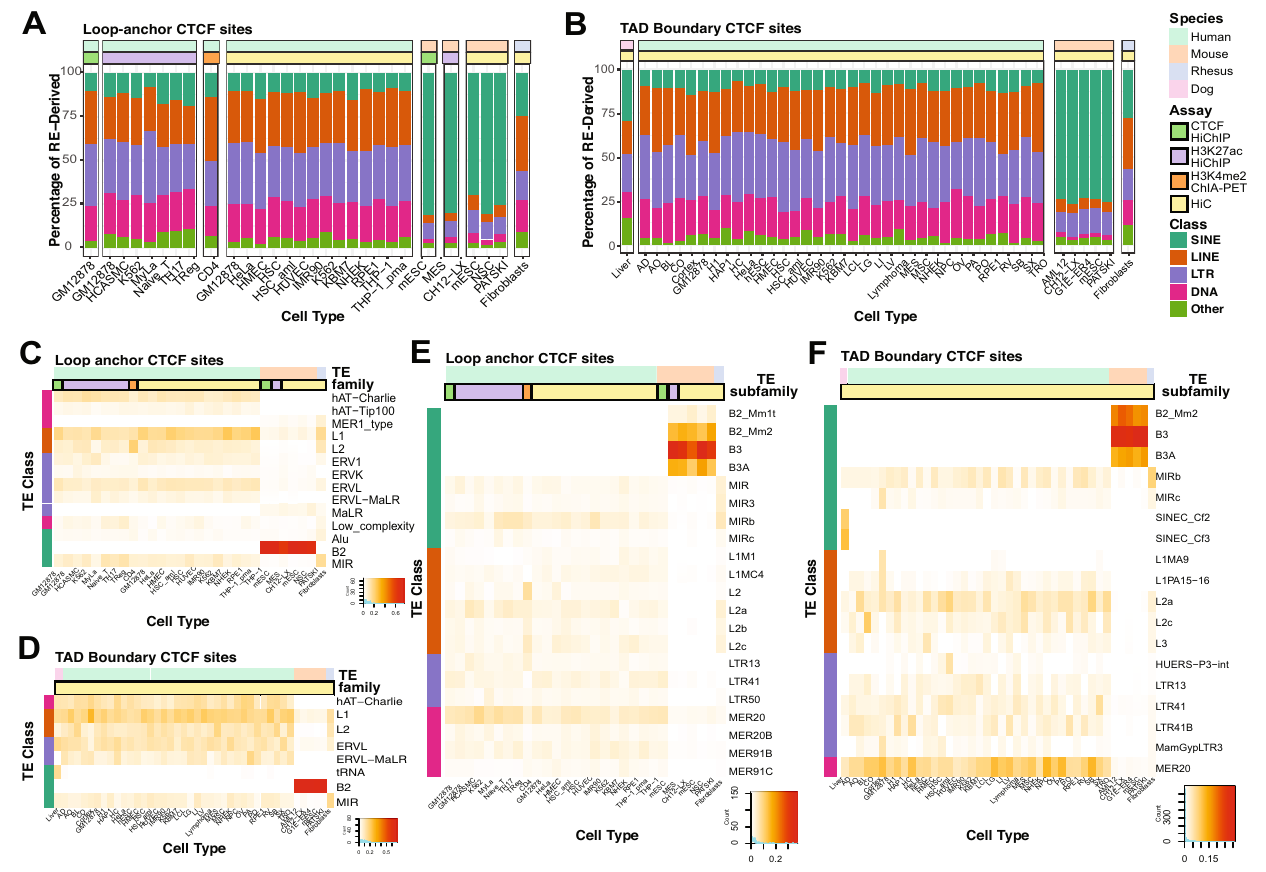
Fig.2|Contributionofrepeatsclass,family,andsubfamilytoloopanchorand TAD boundary CTCF sites. A Stacked bar plots showing the distribution of RE- derived loop anchor CTCF binding site across major RE classes in the various cell types. B Stacked bar plots showing the distribution of RE-derived TAD